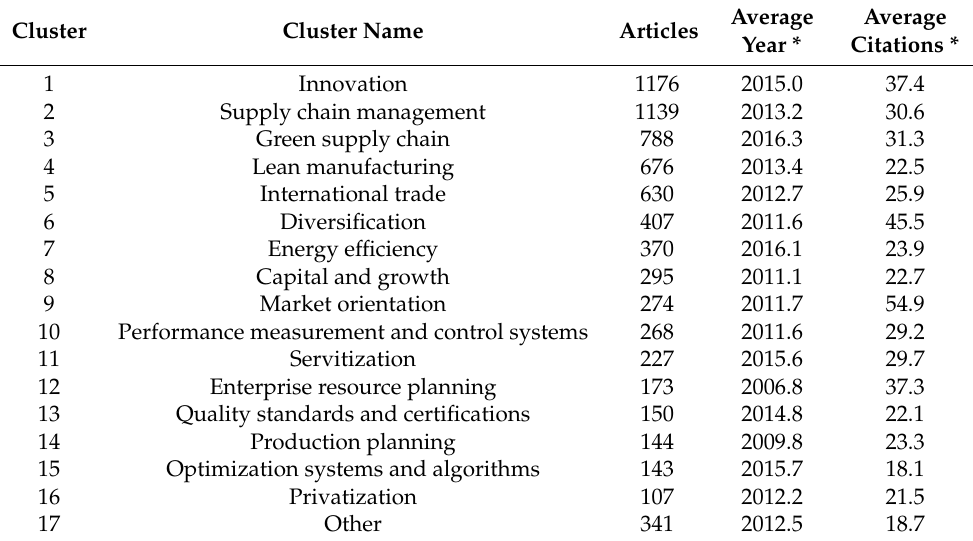
Figure 4. Citation network of manufacturing enterprise performance research. Each colored section represents one of the 17 clusters that were identified; the six largest clusters are labeled. Table 1. Clusters for manufacturing enterprise